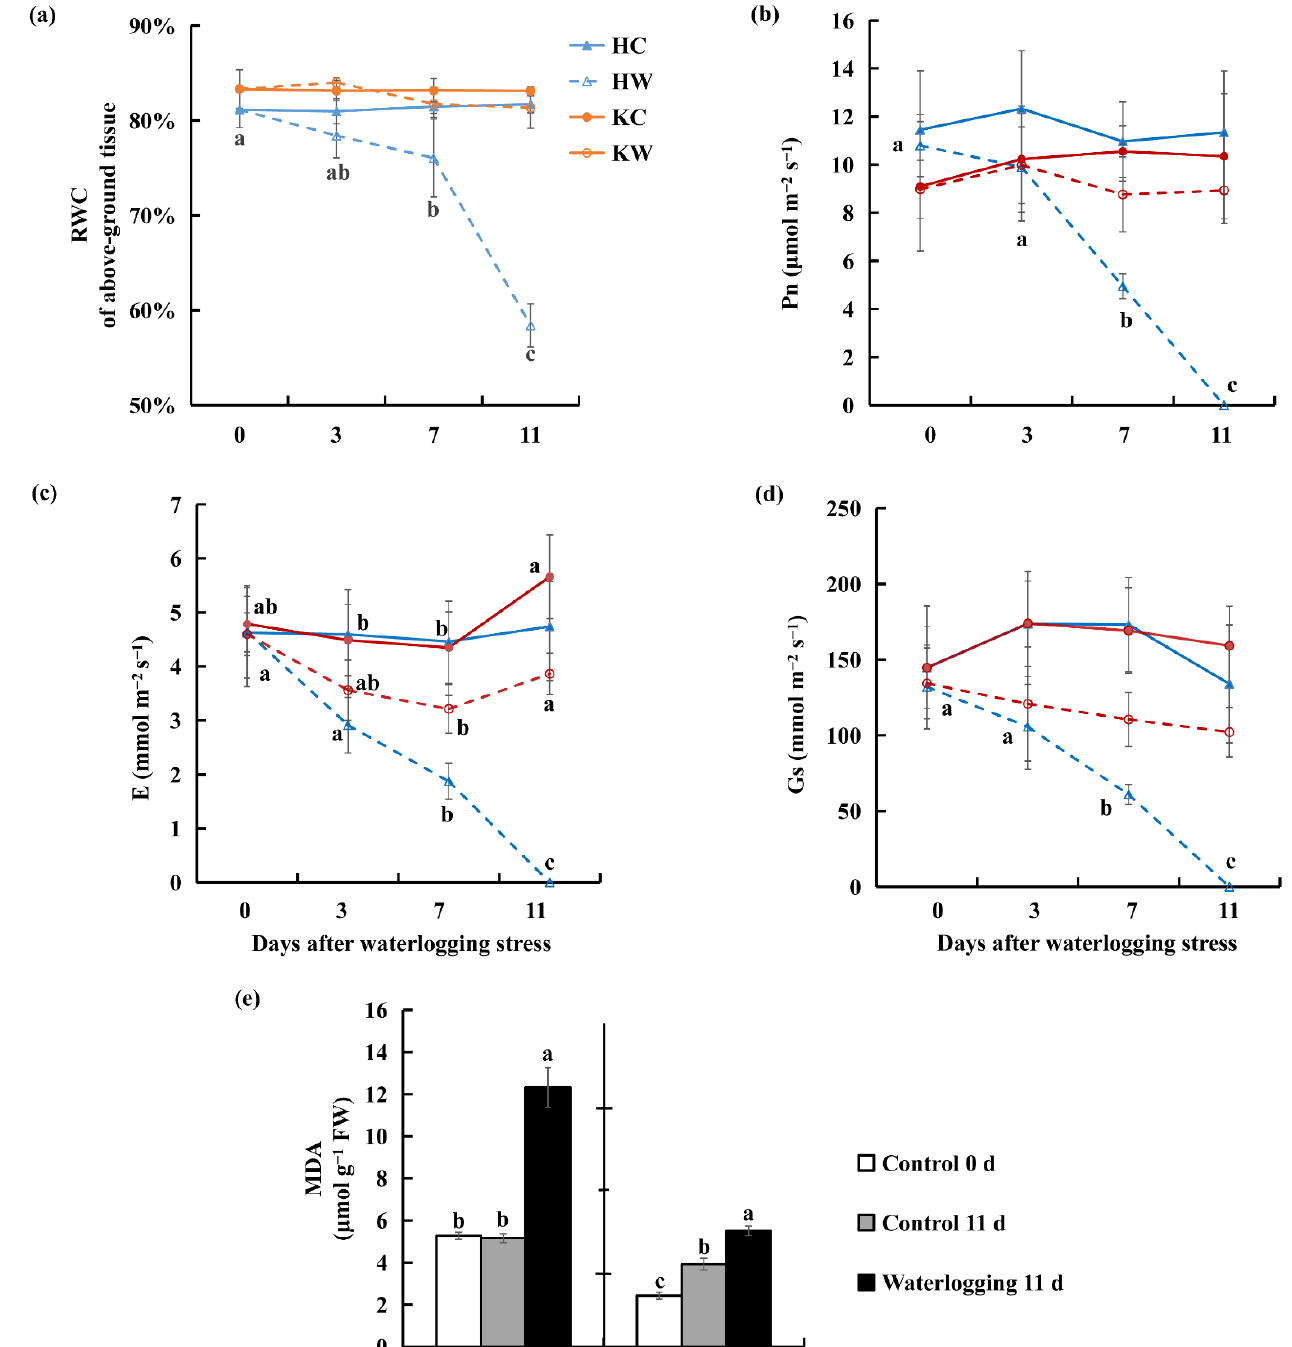
Figure 2. Relative water content (RWC), gas exchange data, and malondialdehyde (MDA) content of KR5 and ’Hayward’ plants under waterlogging stress. ( a ) RWC of aboveground tissue; ( b ) net photosynthetic rate, Pn; ( c ) transpiration rate, E; ( d ) stomatal conductance, Gs, and ( e ) MDA content of leaf. HC, control of ’Hayward’ ; HW, waterlogging of ’Hayward’ ; KC, control of KR5; KW, waterlogging of KR5; FW, fresh weight. Values are the mean ± SD ( n = 6). Mean separations are compared statistically among different durations of waterlogging per genotype of rootstock per treatment by analysis of variance (ANOVA) at the 0.05 level of confidence, and significant differences are indicated by different letters (Fisher’s least significant difference test).